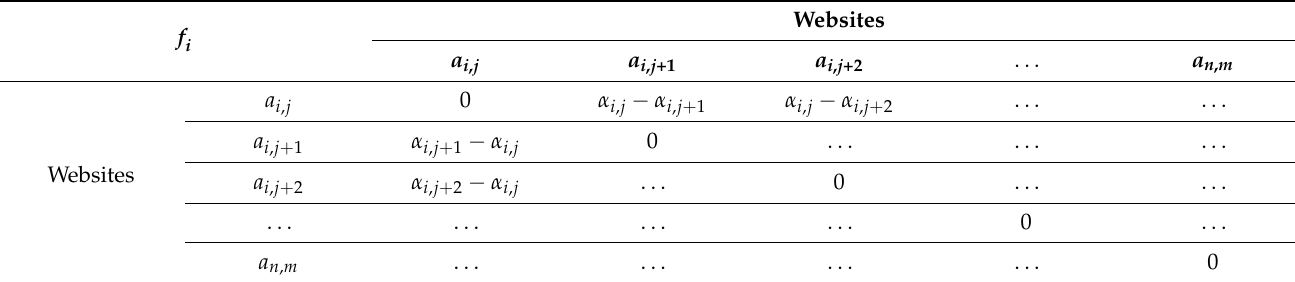
Table 3. Matrix of transformations for each